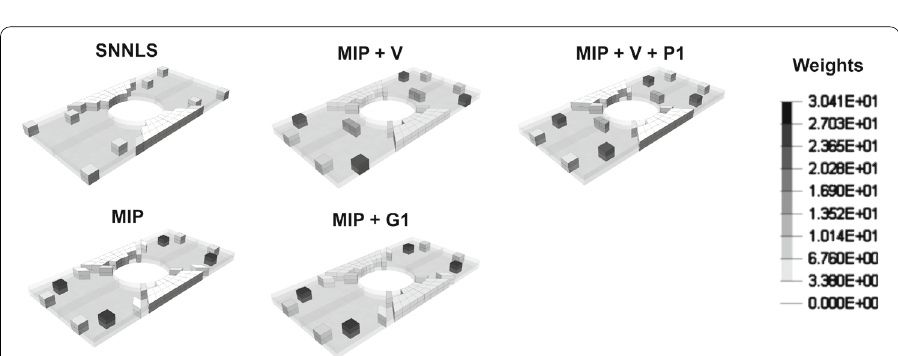
Fig. 7 Element selection for the hyper-reduced integration schemes of size ten computed with the different methods